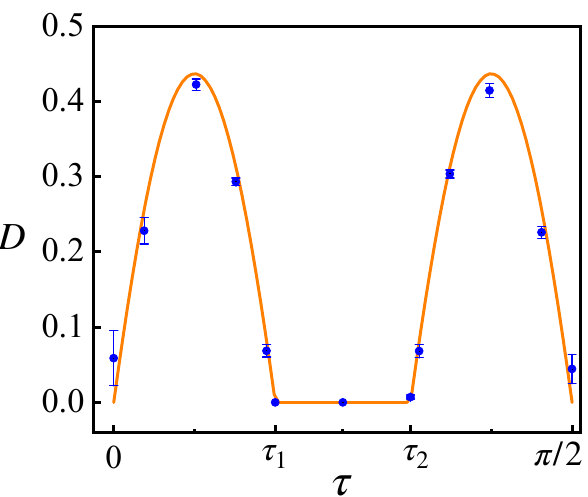
Figure 2. The defined distance D as a function of the evolution time parameter τ for the maximally entangled state. Outside the interval τ 2 > τ > τ 1 (with τ 1 = 1 the measured D is always non-zero, indicating the presence of entanglement in the initial state ρ SE . The solid orange curve indicates the theoretical predictions and the blue symbols denote the experimental results. Error bars indicate the statistical uncertainty, which is obtained from a Monte-Carlo simulation by assuming Poisson distribution of the photon